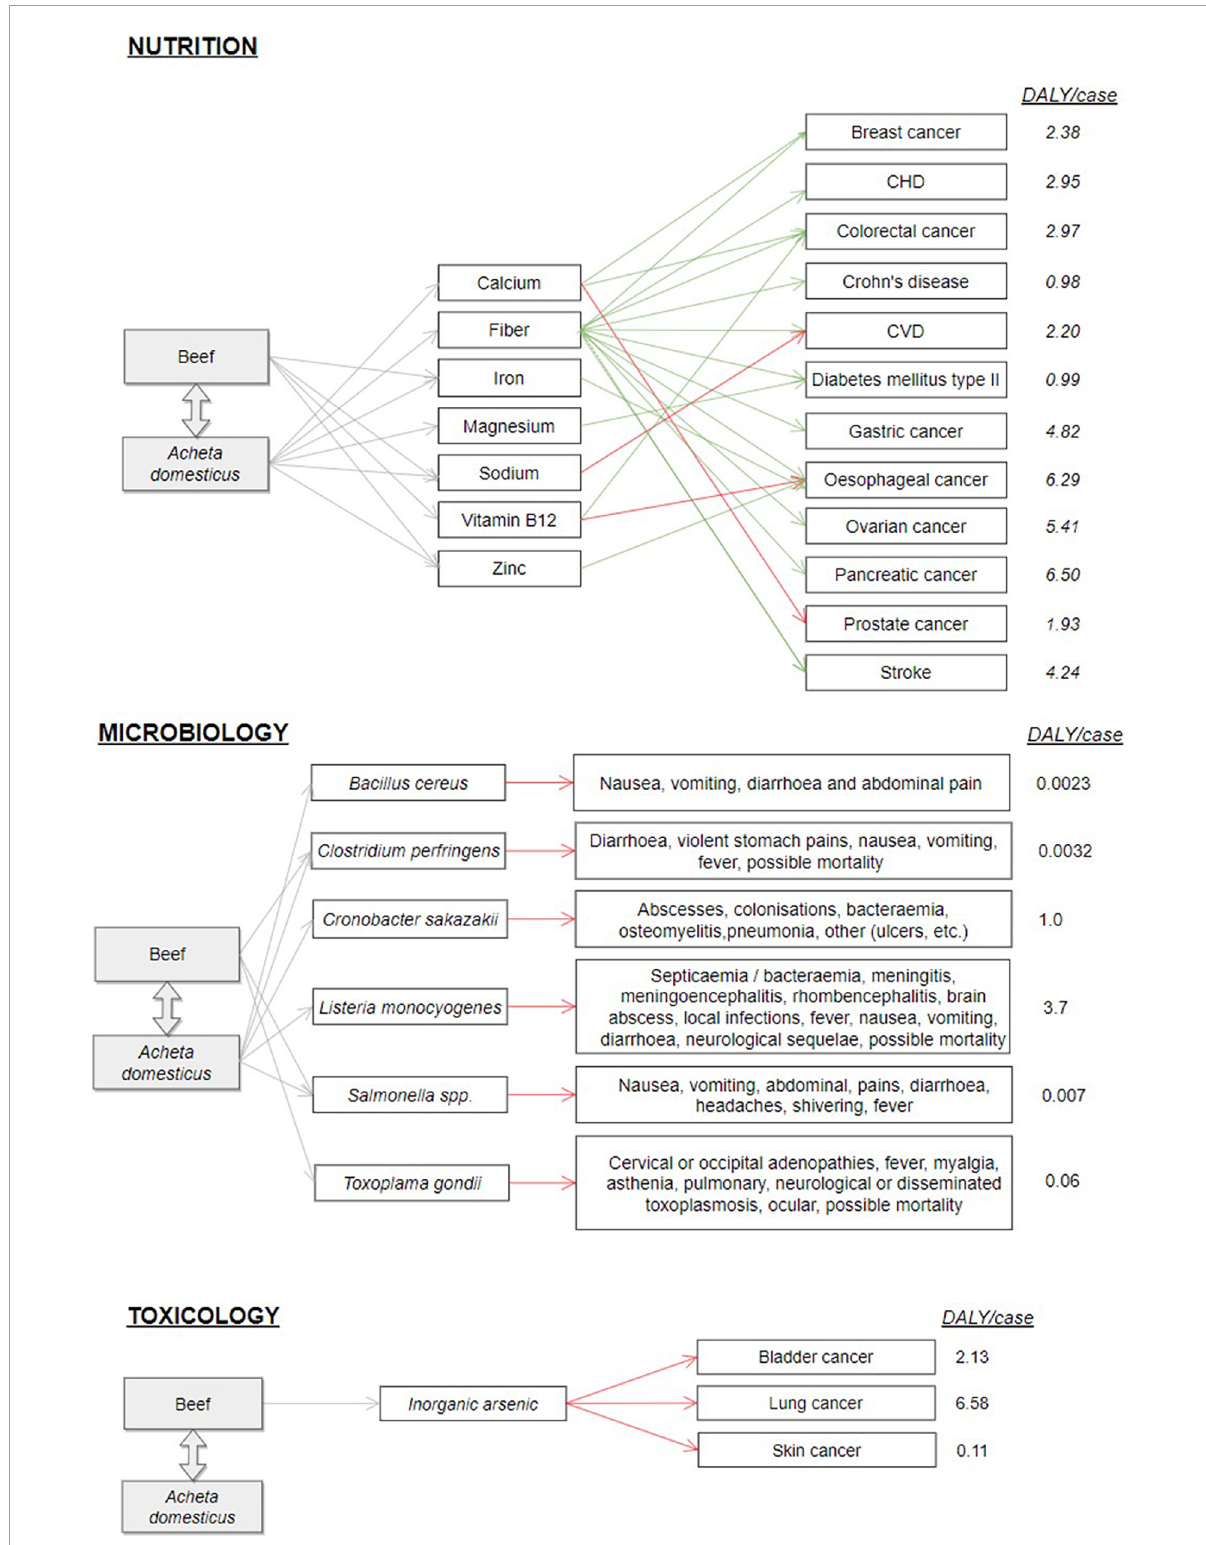
FIGURE7 Tree of components of the final list and associated health outcomes identified in the NovRBA case study (red when the expected effect is negative and green when it is beneficial).